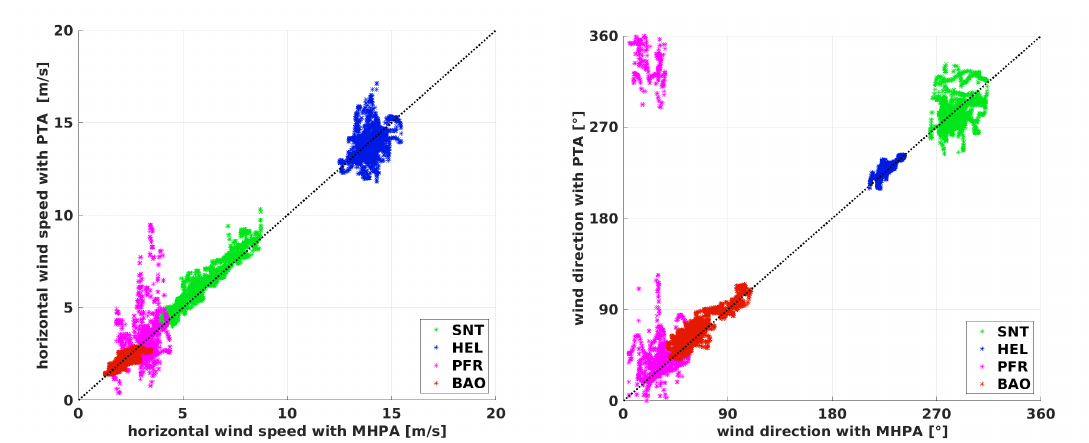
Figure 13. Comparison of the horizontal wind speed ( left ) and the wind direction ( right ) on a window of 1 min for the flights at the Boulder Atmospheric Observatory (BAO), Schnittlingen (SNT), Helgoland (HEL), and Pforzheim (PFR). The black dashed line shows the bisecting line where the multi-hole-probe algorithm (MHPA) equals the pitot tube algorithm (PTA). The data is calculated on a window with M = 60 s. The results from the MHPA are plotted against the results from the PTA